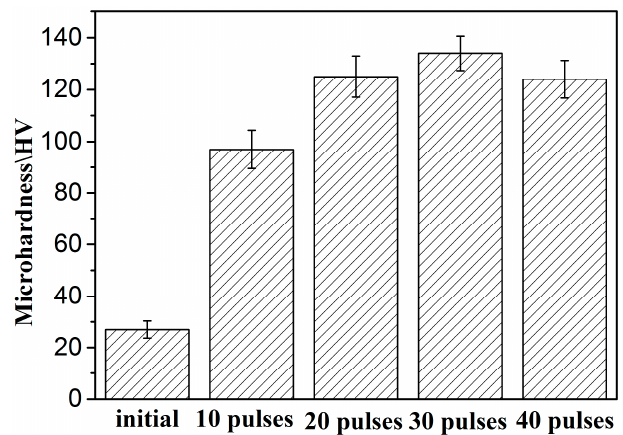
Figure 7. Microhardness measurements of the alloyed sample before and after HCPEB irradiation.